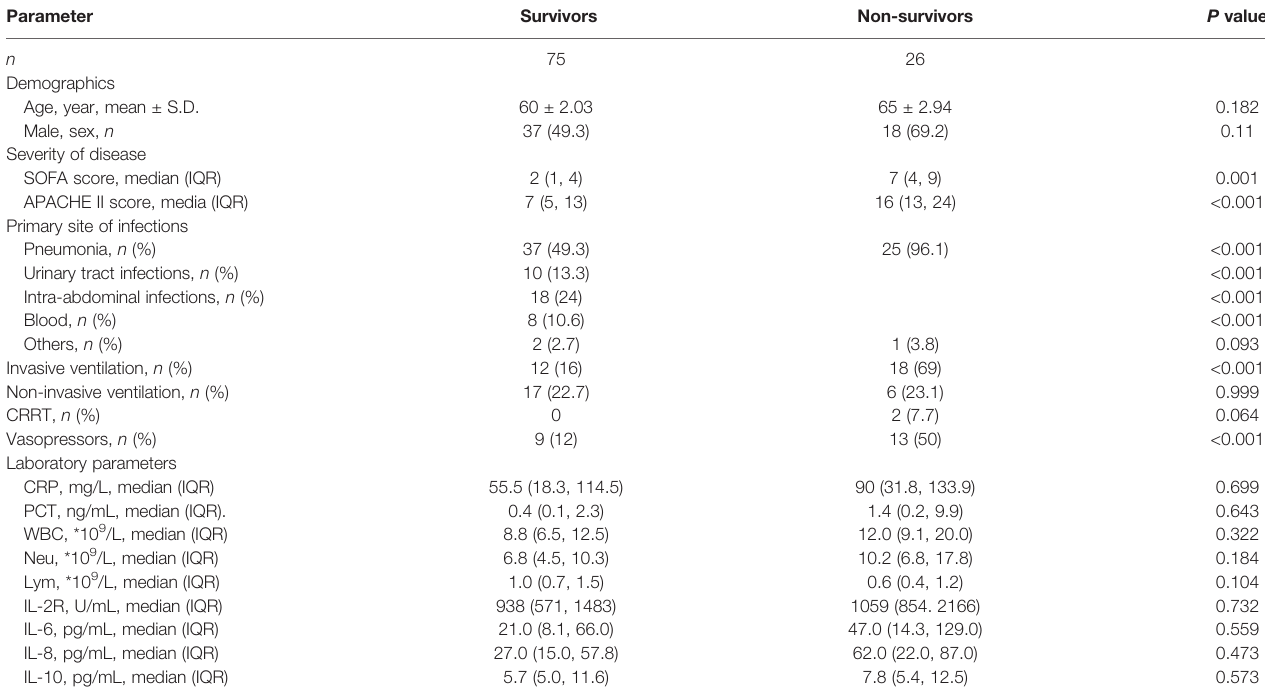
TABLE 2 | Baseline characteristics of survivors and non-survivors in septic patients at ICU